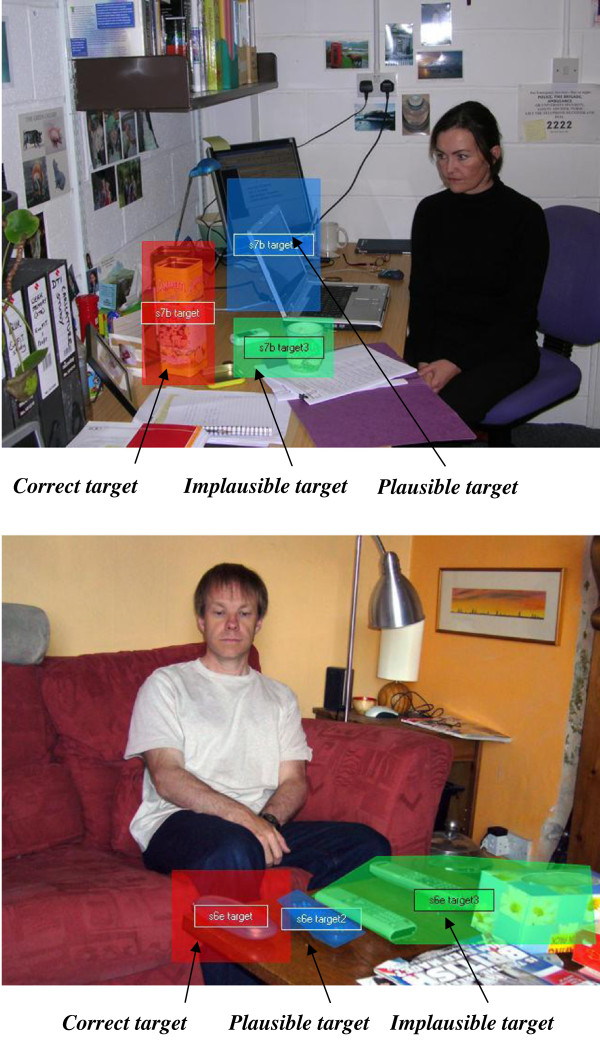
Examples of two scenes used in the study with the target items highlighted. All images were shown in full color during the experiment and are available in Additional file 1. Those portrayed in these images are volunteers who consented to the use of their images in the study, not participants.